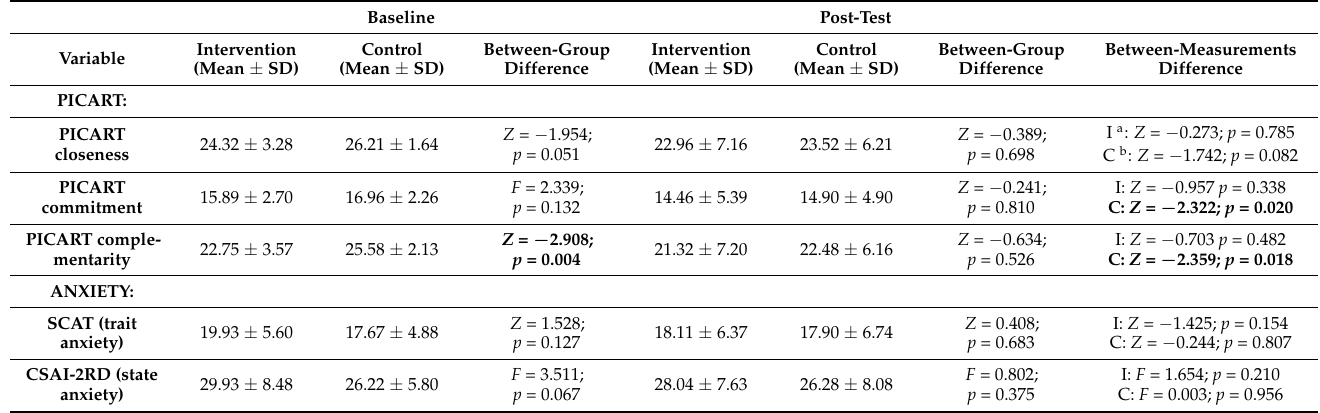
Table 4. The differences in the mean scores obtained for the PICART, SCAT and CSAI-2RD variables between groups (intervention vs. control) and between measurements (baseline vs.